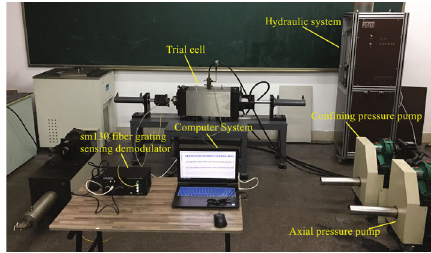
Figure 5: Test equipment